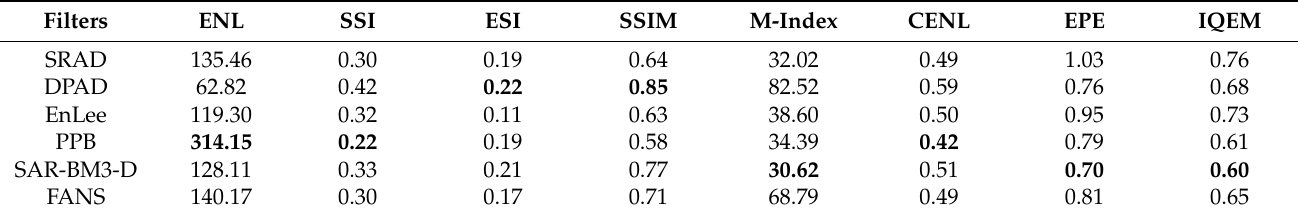
Figure 12. ( a1 ) Noisy ALOS-2 SAR image. Filtered images by the ( b1 ) SRAD filter, ( c1 ) DPAD filter, ( d1 ) EnLee filter, ( e1 ) PPB filter, ( f1 ) SAR-BM3-D filter, and ( g1 ) FANS filter. ( a2 – g2 ) are the enlarged images of region 1 from ( a1 – g1 ). Table 7. Index evaluation of the ALOS-2 SAR image.